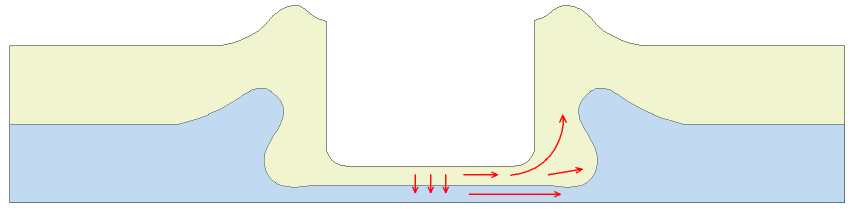
Figure 9. Material flow to increase the interlock and neck thickness.